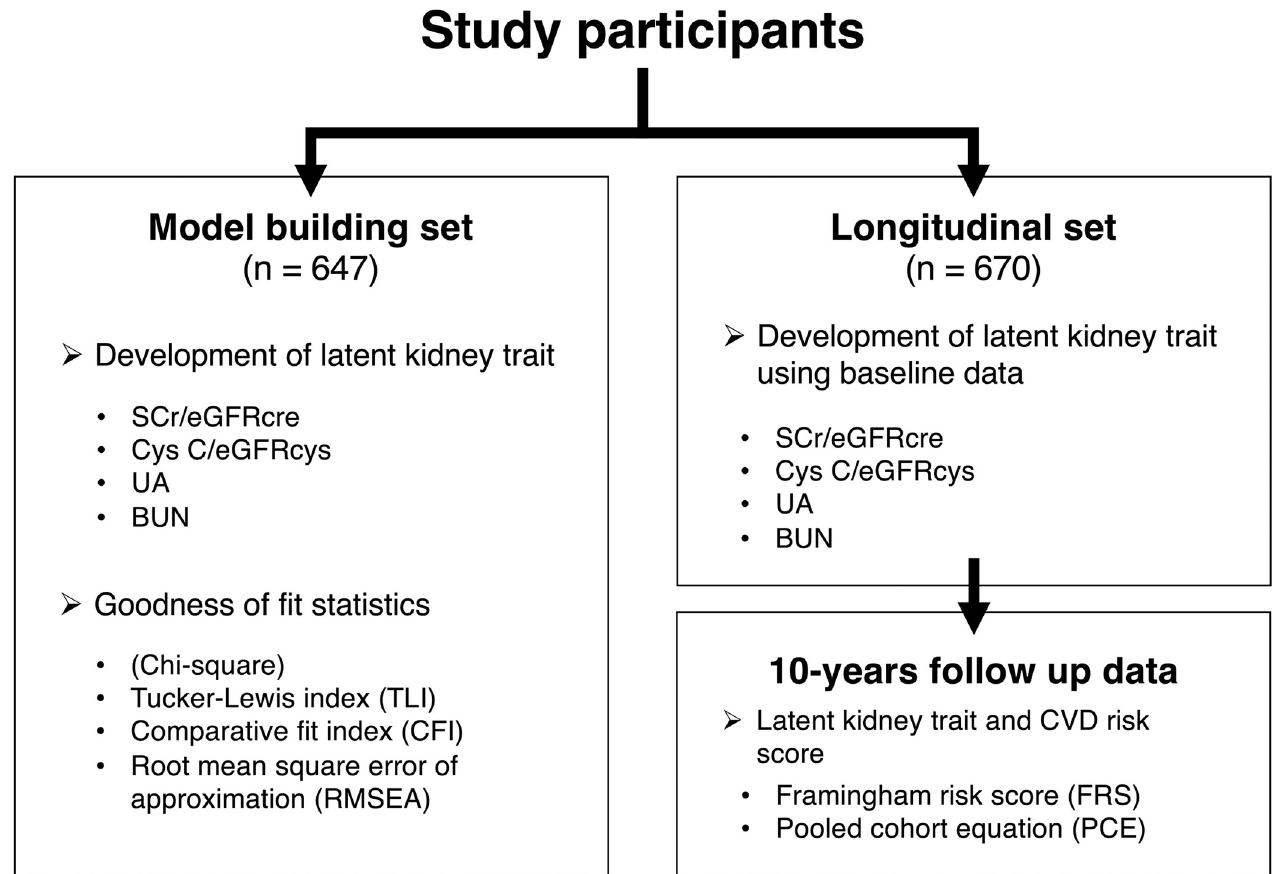
Fig 1. Analysis flowchart. All study participants are divided into two parts: Model building set (n = 647, left panel) and Longitudinal set (n = 670, right panel).